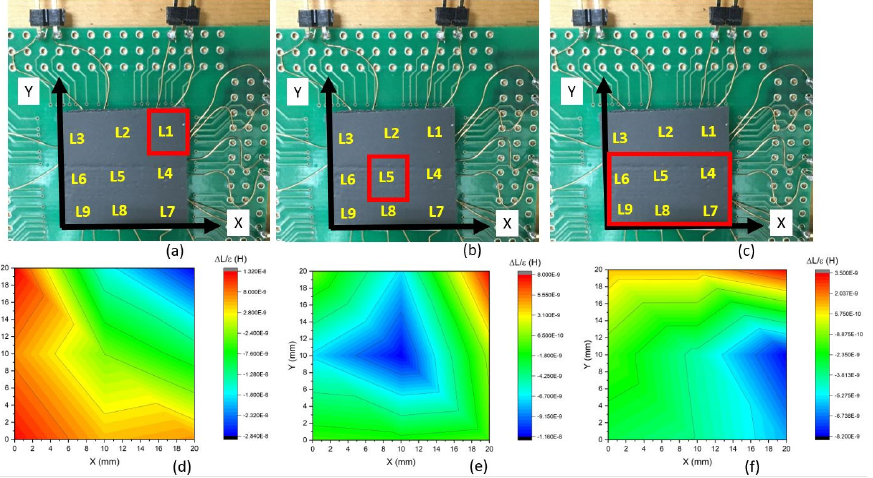
Figure 9. Applied compressive displacement localization ( a – c ) and the resulting α (x,y) map ( d – f) : blue and green refer to negative coefficient values (compression), whereas yellow and red refer to positive coefficient values.